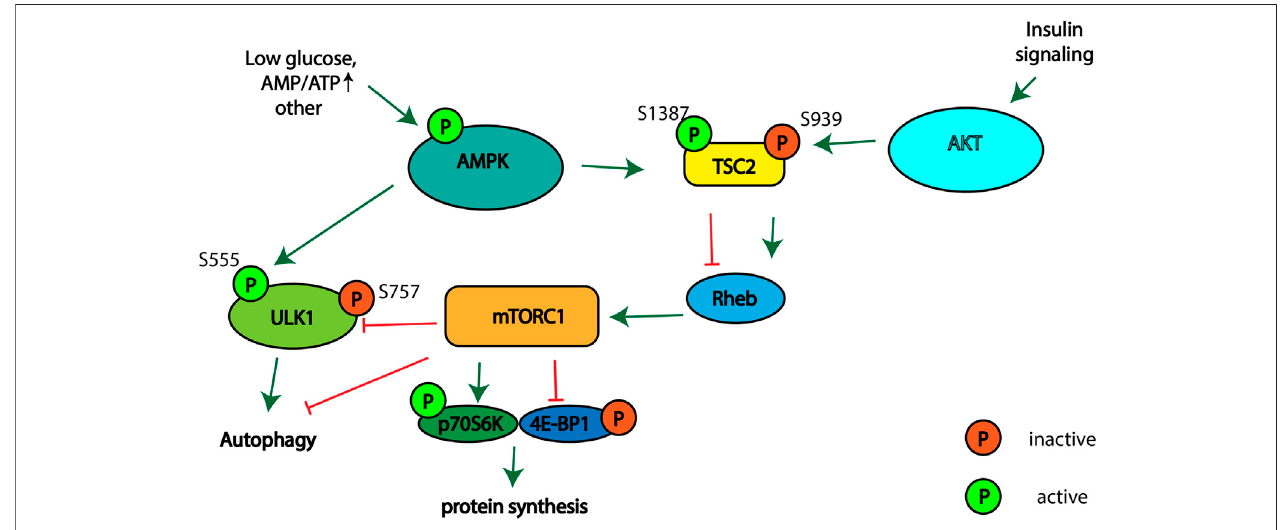
FIGURE 1 | Schematic illustrating the signaling pathways involved in regulation of mTORC1 activity, autophagy, and protein synthesis.